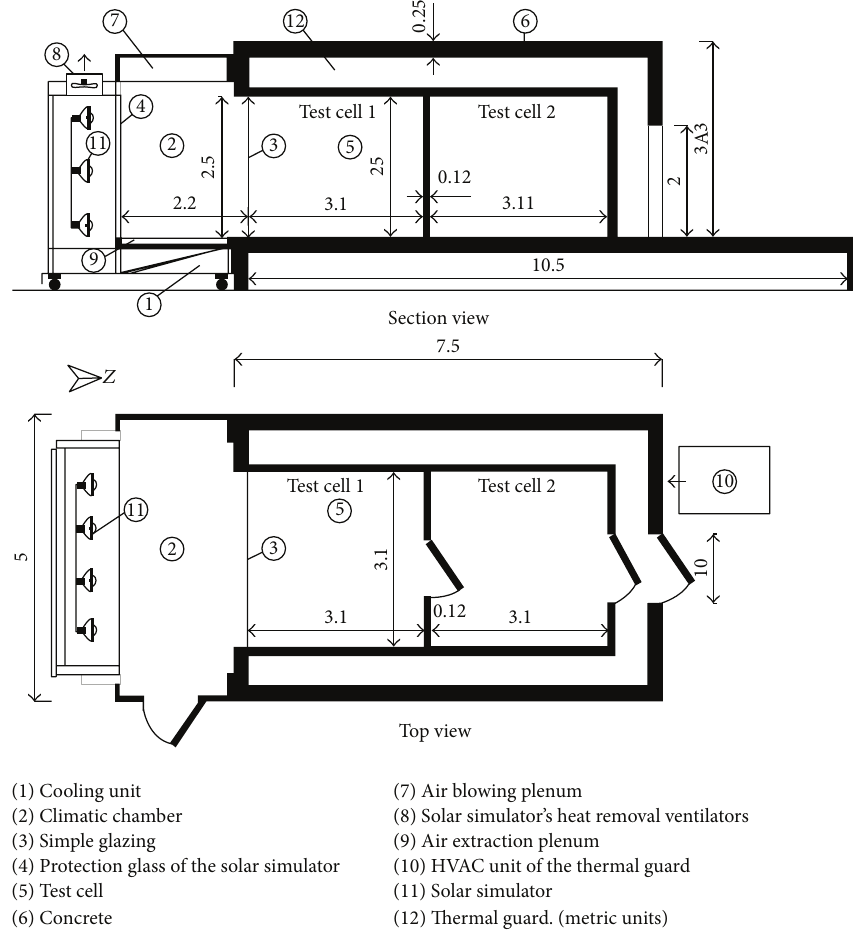
Figure 3: Scheme of the experimental